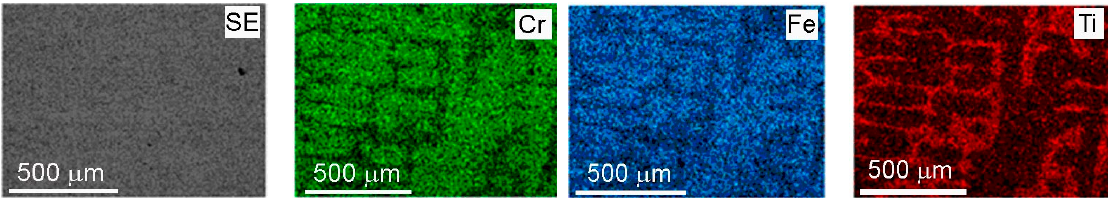
Figure 6. EDX-mapping of homogenized and quenched sample (CoCrFeMnNi) 100-5 Ti 5 . Reprinted with permission from Ref. [37]. Copyright 2021 Elsevier.